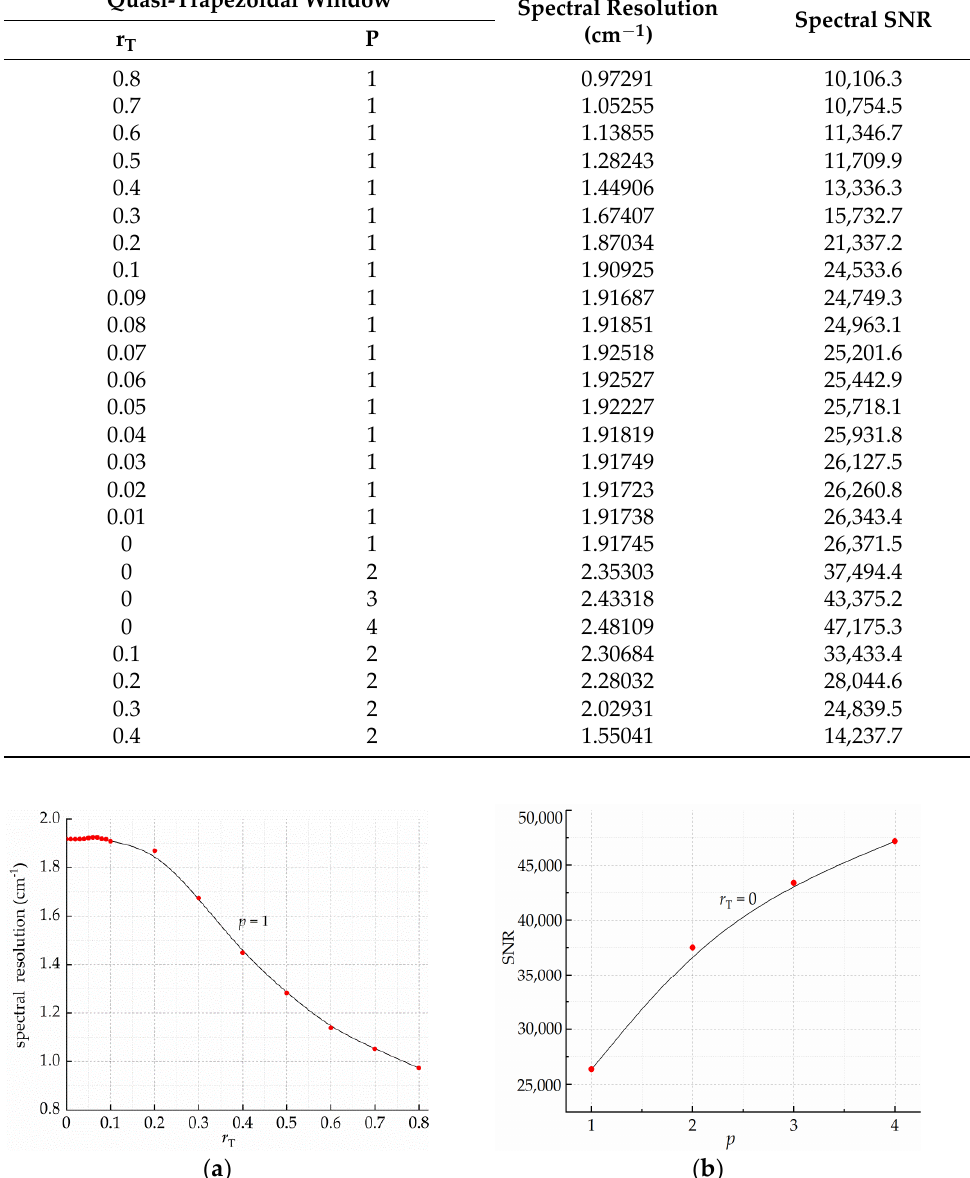
Table 6. Spectral resolution and SNR based on the quasi‑trapezoidal window function.